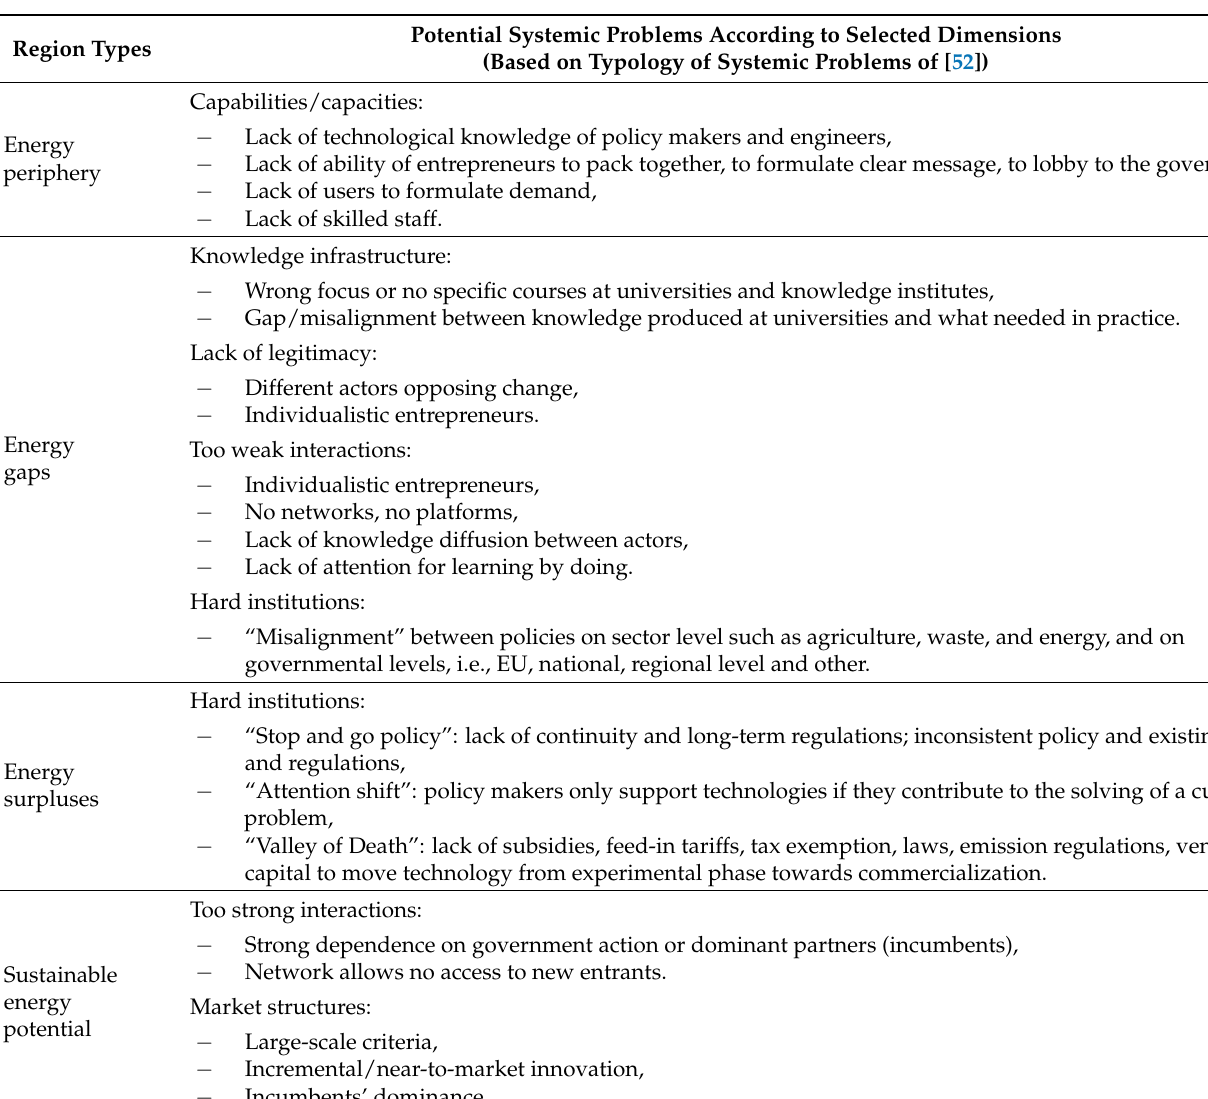
Table 4. Potential systemic problems in regions depending on their renewable energy generation. Potential Systemic Problems According to Selected Dimensions Region Types (Based on Typology of Systemic Problems of